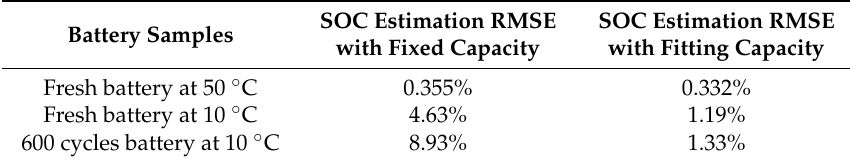
Figure 8. SOC estimation results with fixed and fitting capacity, ( a ) SOC estimation for flash battery at 50 °C; ( b ) SOC estimation for flash battery at 10 °C; ( c ) SOC estimation for 600 cycles battery at 10 °C. Table 2. SOC estimation root mean squared error (RMSE) with fixed capacity and fitting capacity.